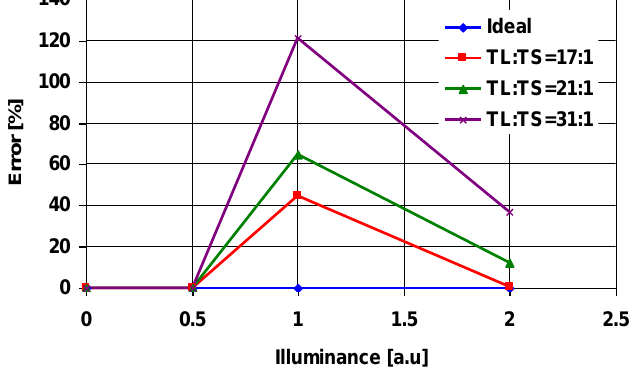
Figure 11. Non-linearity in high illumination region (error in